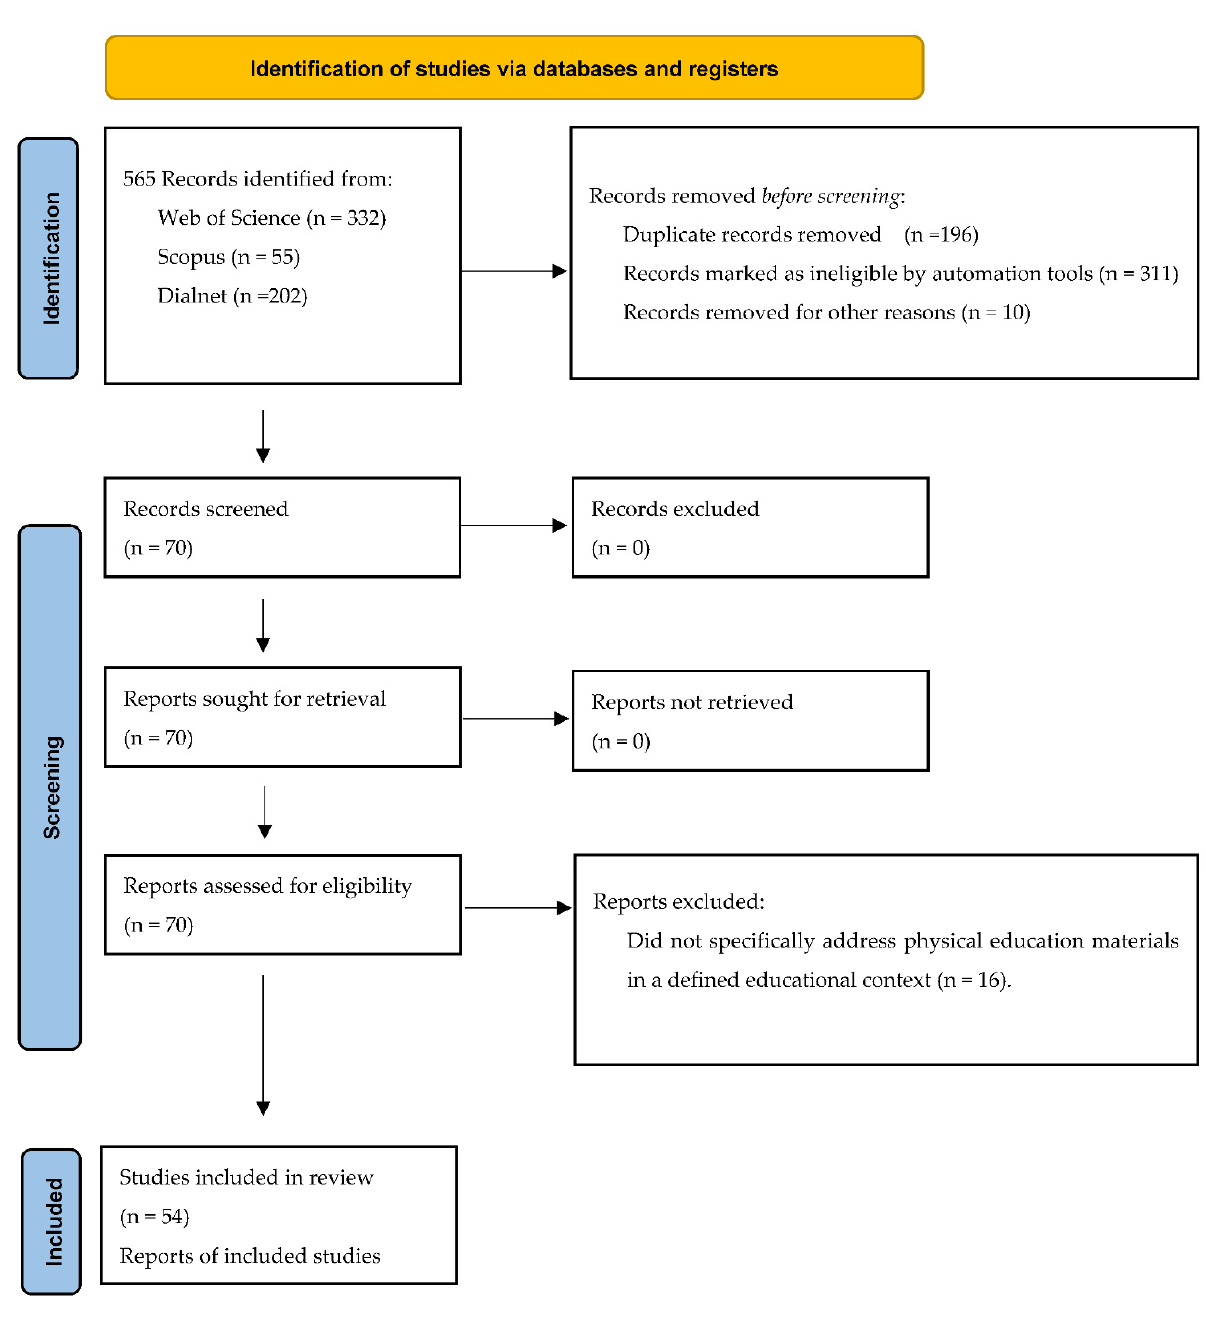
Figure 1. Flow diagram of the systematic search process.